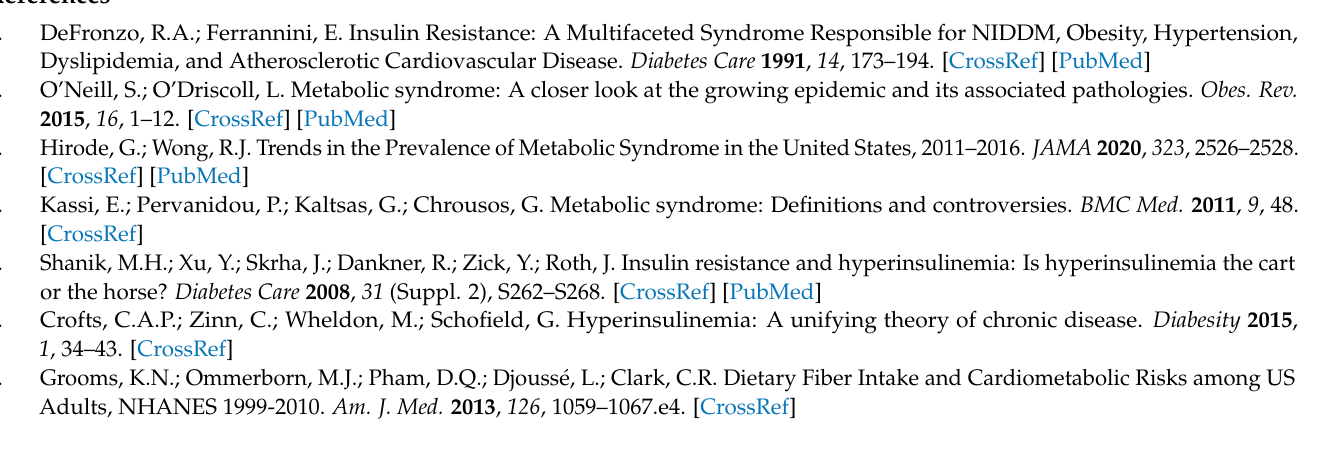
Figure S1: Mean incremental blood glucose values from 20 participants over 60 min, after consuming either whole fruit (solid line) or blended fruit (broken